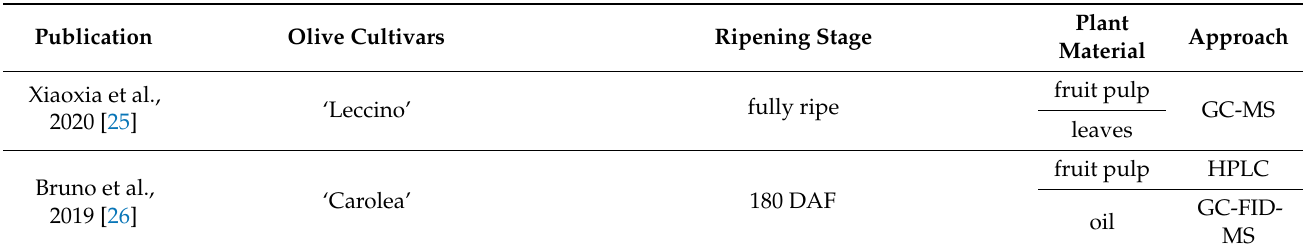
Table 5. Analytical techniques that have been used in recent literature, providing a great amount of metabolomic data in order to interpret olive’s ripening complex regulation and